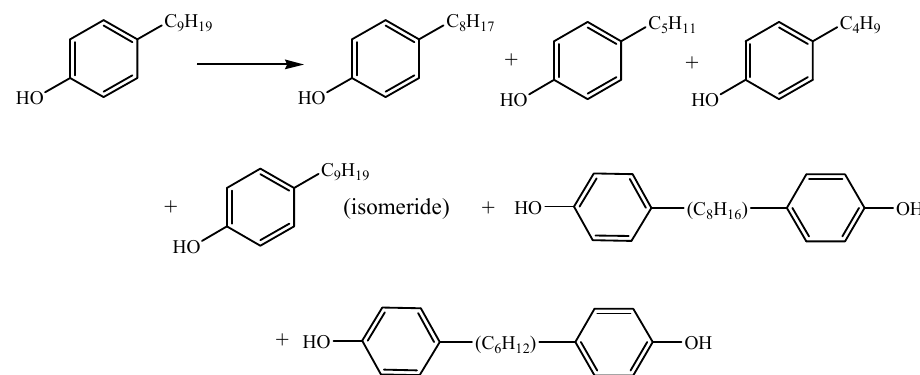
Figure 13. Diagram of the aquathermolysis reaction mechanism of nonylphenol.